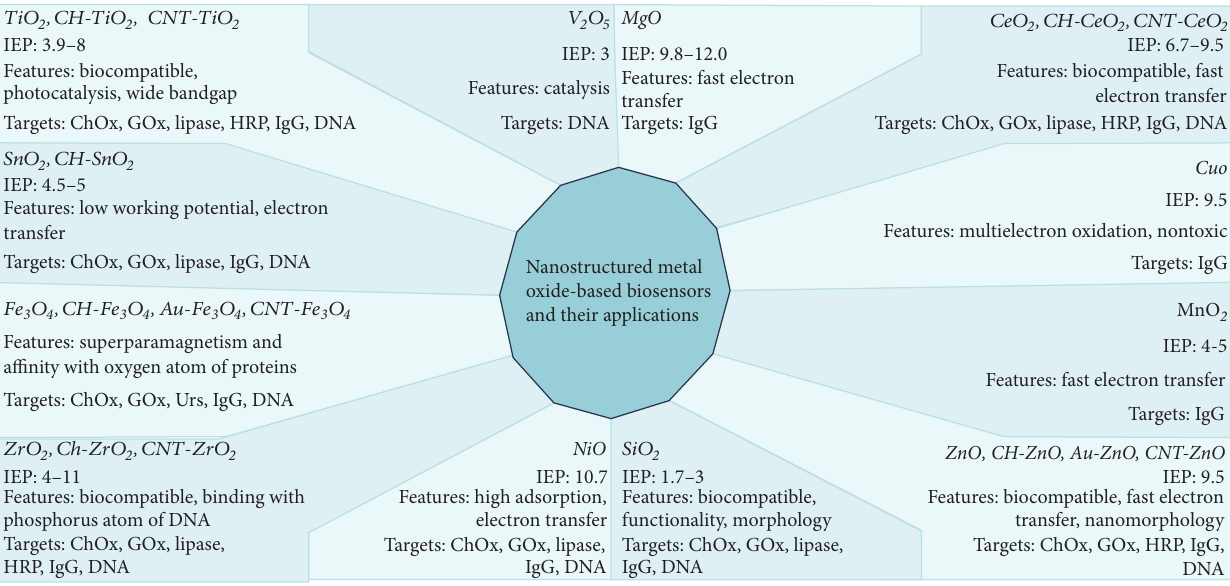
results revealed a refractive index sensitivity dependence on coated FBG was higher than the uncoated